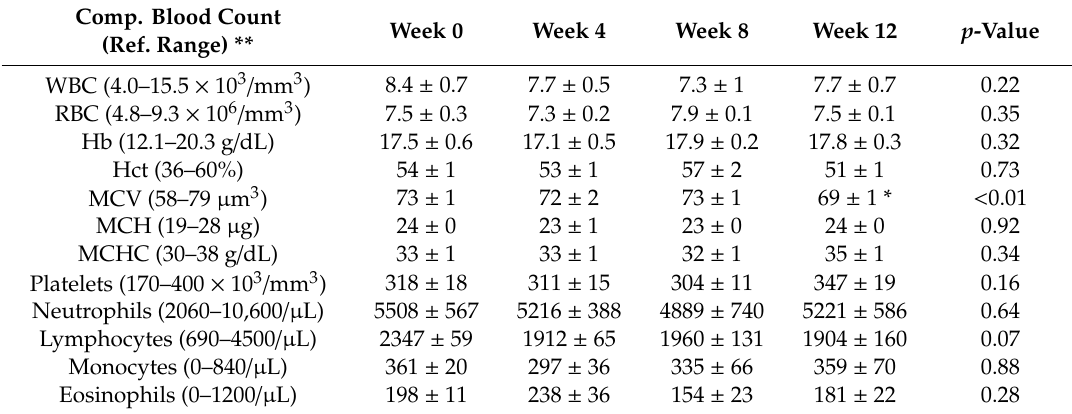
Table 3. Dog ( n = 8) complete blood count means and SEM immediately prior to (week 0), 4 weeks, 8 weeks and 12 weeks of an oral 2 mg / kg CBD dose twice daily using a CBD-rich hemp product.